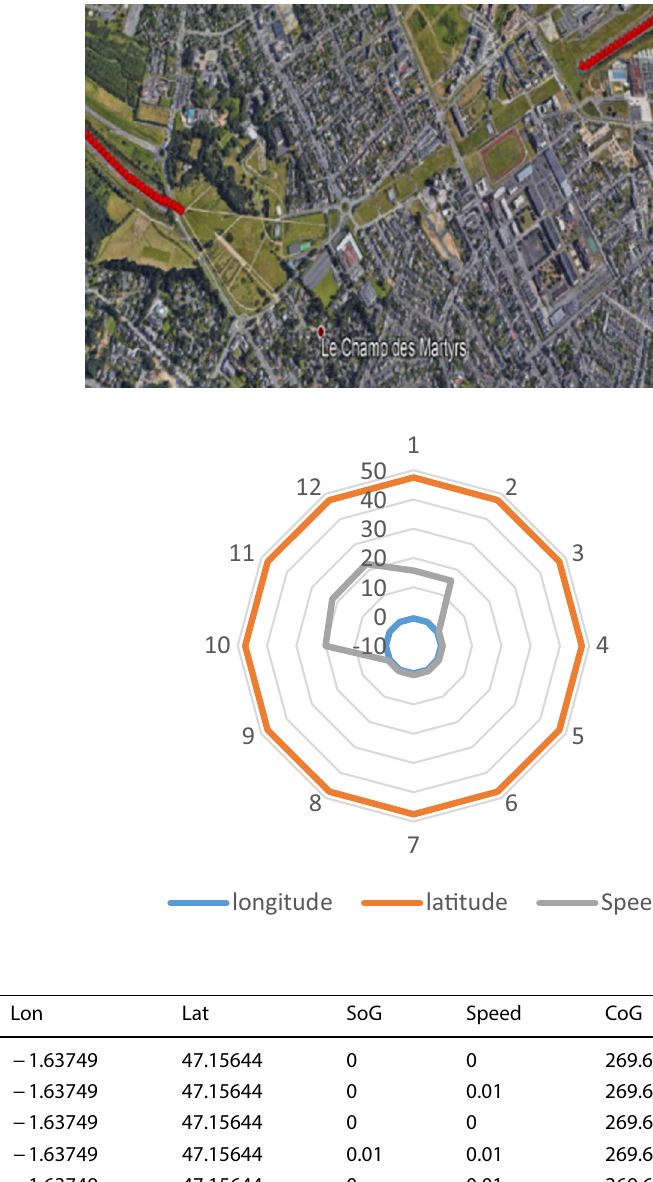
Fig. 11 Incomplete data